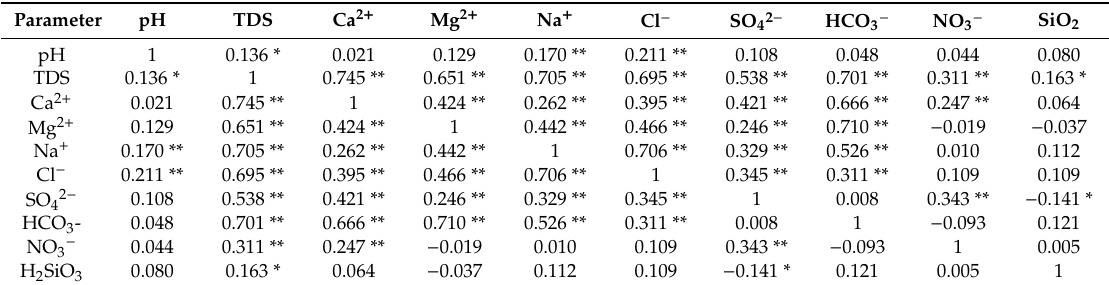
Table 3. Pearson correlation (r) for the hydrogeochemical parameters of the shallow groundwater in the Su-Xi-Chang region.